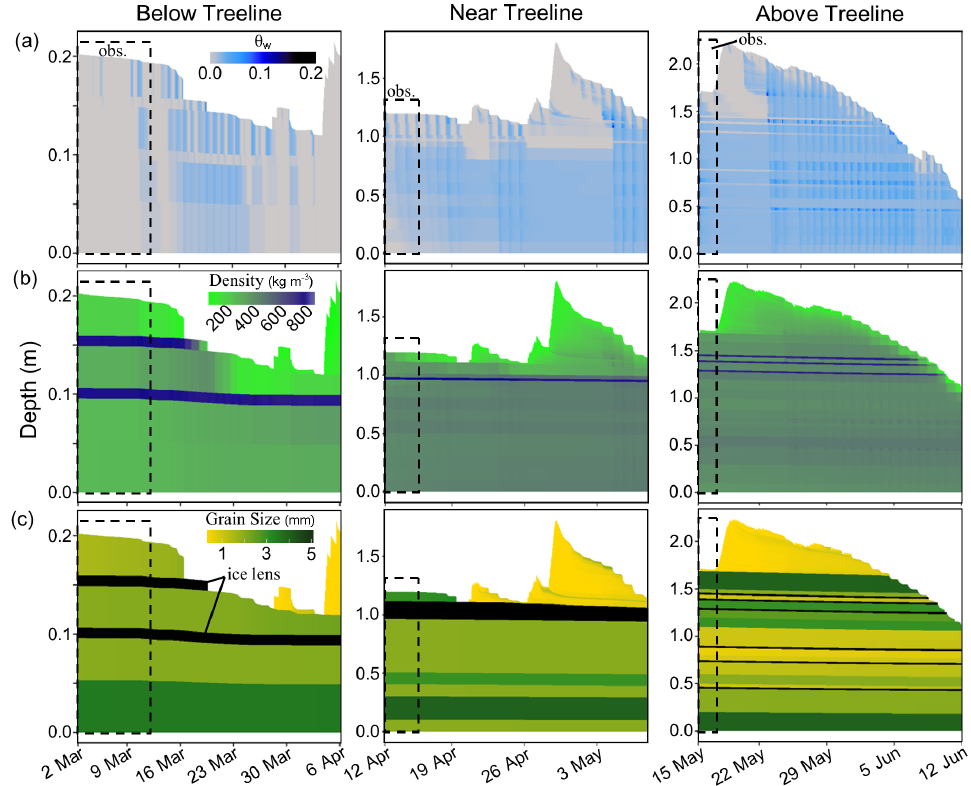
Figure 3. Results of SNOWPACK simulations of the intensive observation periods (IOPs) for below-treeline (BT), near-treeline (NT), and above-treeline (AT) study sites. Results shown are (a) volumetric liquid water content ( θ w ), (b) snow density, and (c) grain size with the observation (obs.) and SnowTOUGH simulation period highlighted in the dashed box. Note that the axes have different scales for each